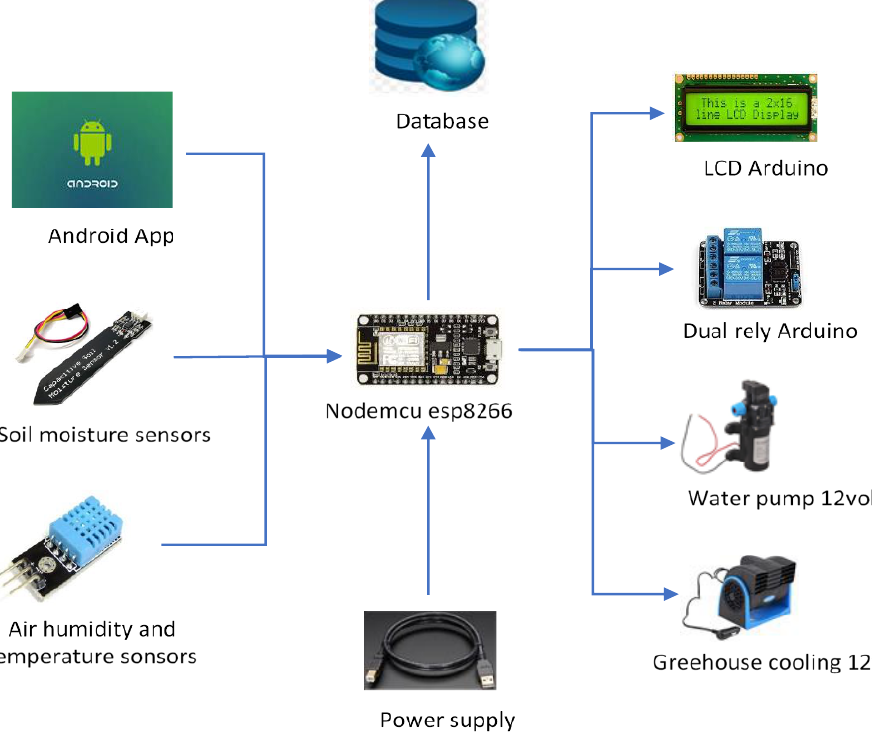
Figure 6. Block Diagram